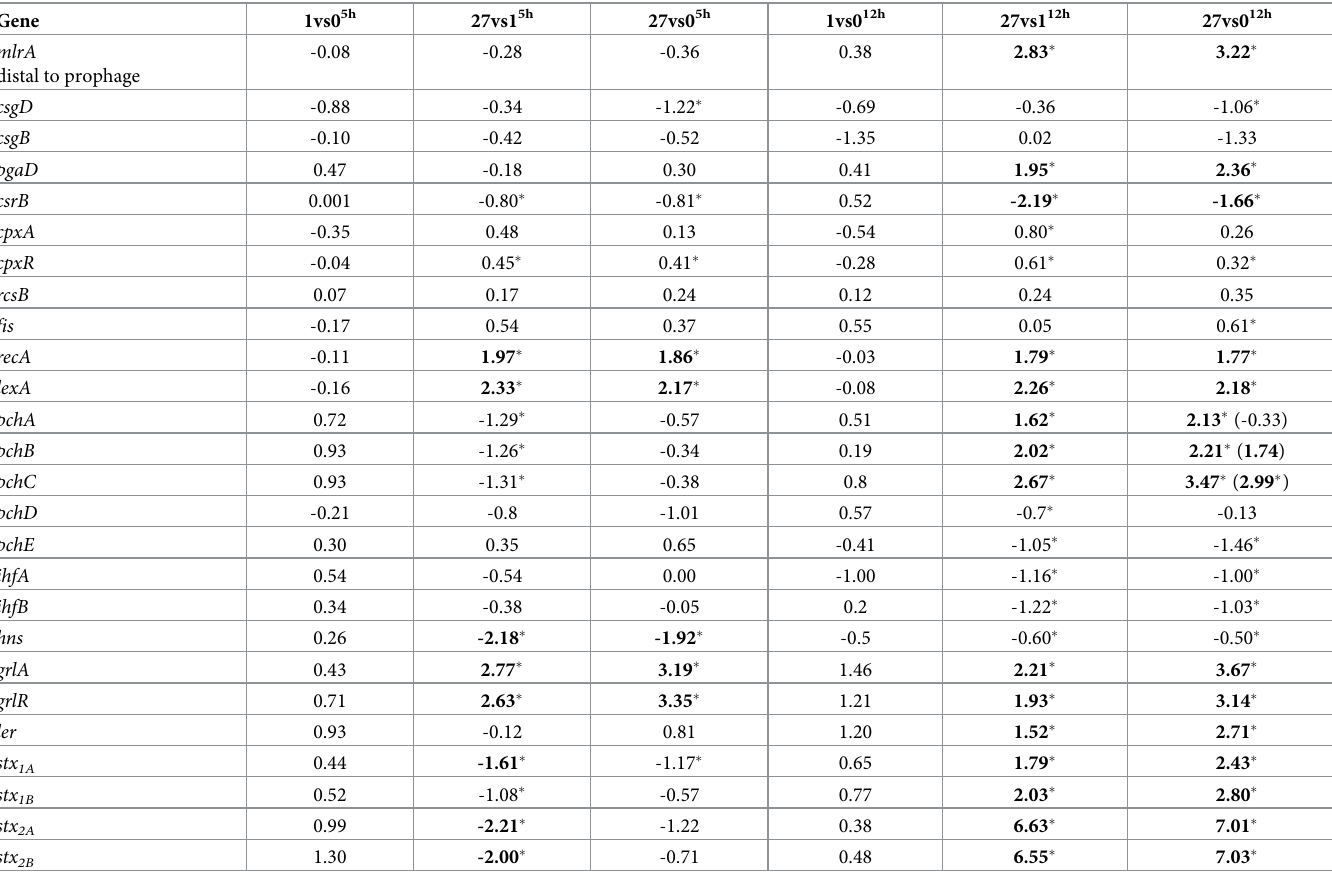
Table 2. Differential expression (log 2 FC) of selected biofilm, virulence, and regulatory genes derived from RNA-Seq comparisons of serotype O157:H7 strain PA20 grown for five hours or 12 hours in LB-NS in the presence of different SMX-TM concentrations as listed. Comparisons with a log 2 FC (cid:21) 1.5 or (cid:20) -1.5 (fold change (cid:21) 3) are shown in